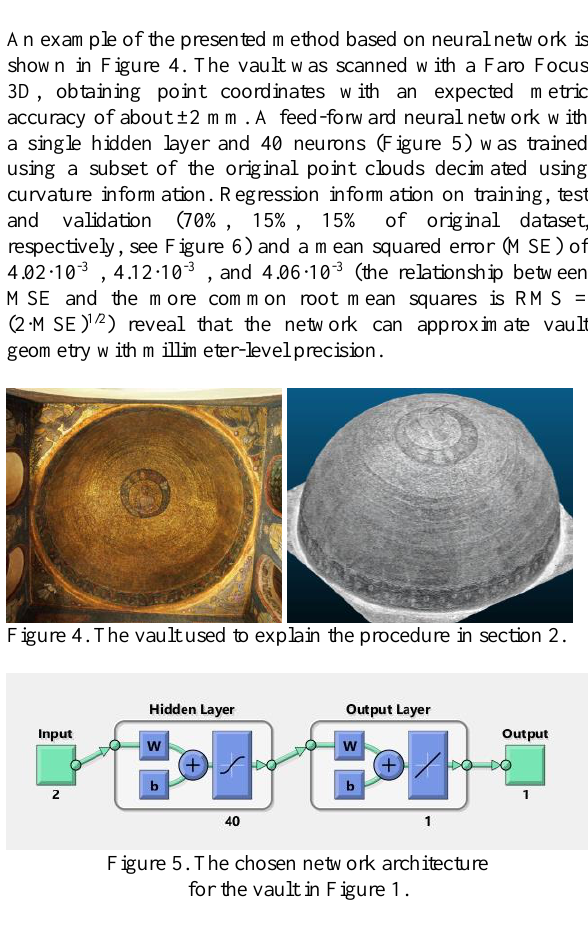
Figure 3. A diagram denoting a neural network with 2 hidden layers.